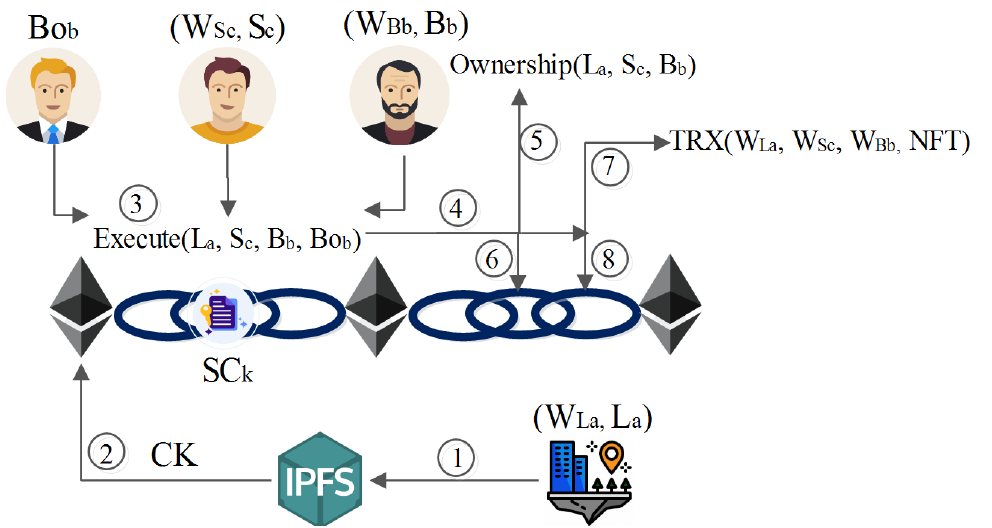
Figure 8. SC execution between